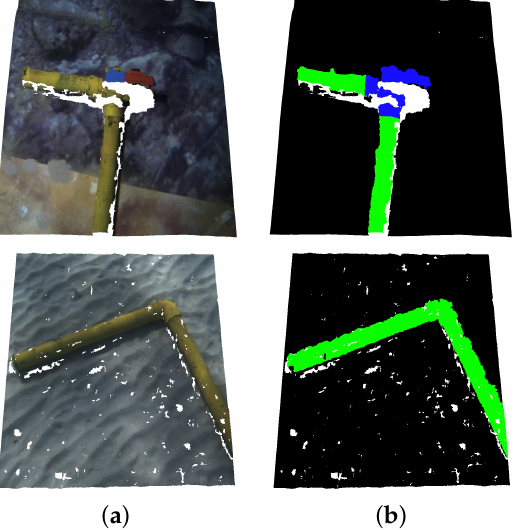
Figure 3. Point cloud labelling: ( a ) Original point cloud; ( b ) Ground truth annotations. Points corresponding to pipes, valves and background, are marked in green, blue and black,